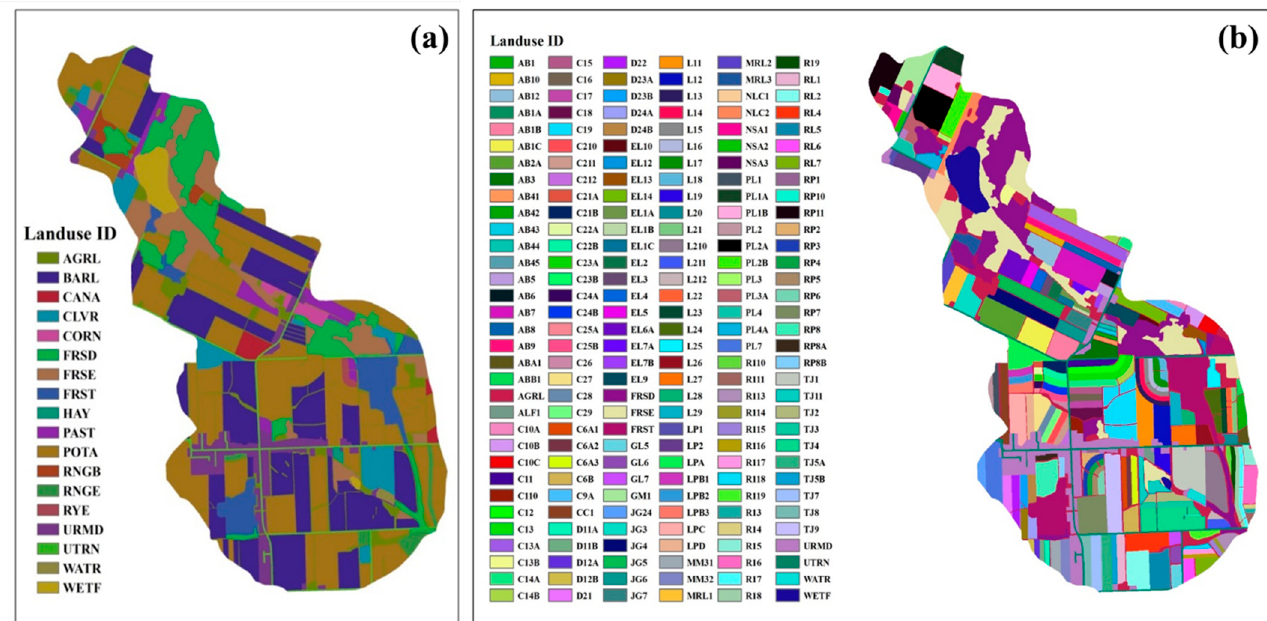
Figure 3. Land use IDs of ( a ) a land use map generated in 2001 and ( b ) in a new version of the land use map.